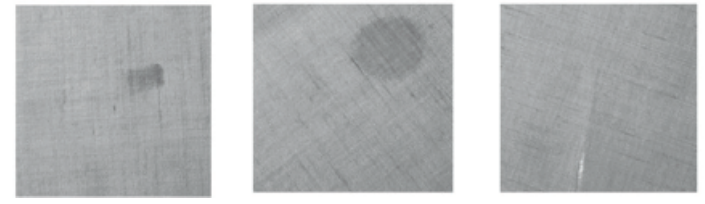
Fig. 10 Typical missed detection pattern under the colour matrix of the centreline of the insulator.